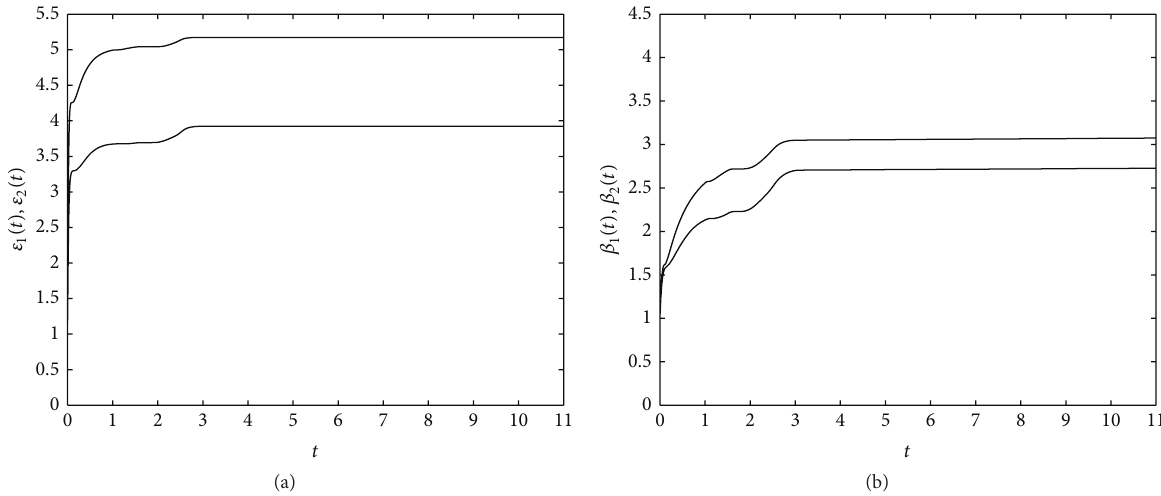
Figure 9: The adaptive pinning control gains of (52): (a) the adaptive pinning control gains 𝜀 𝑖 , 𝑖 = 1,2 . (b) The adaptive pinning control gains , 𝑖 = 1,2 𝛽 𝑖